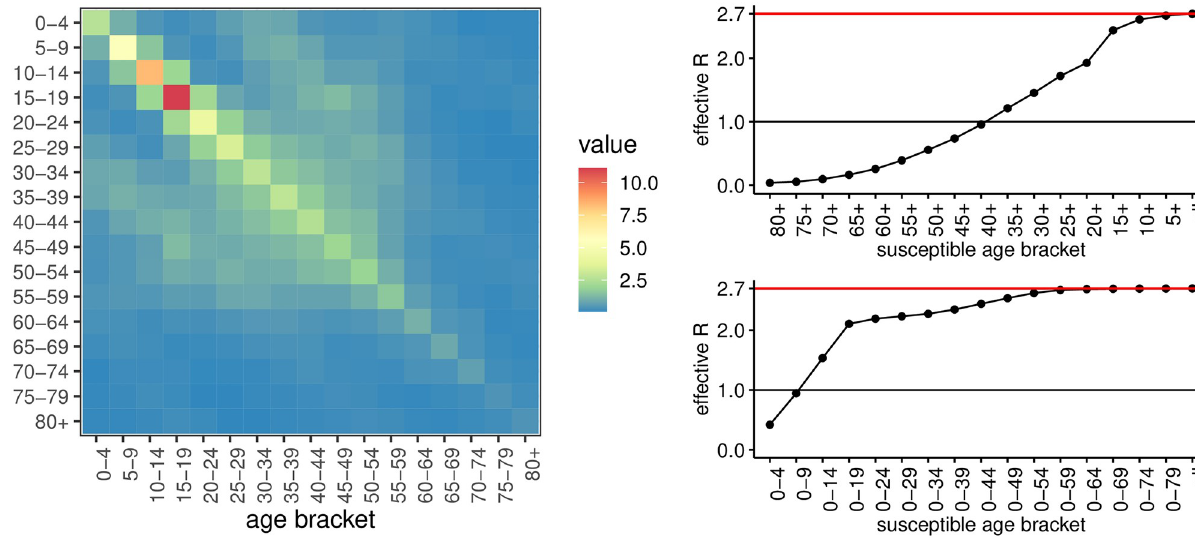
Fig 1. Left : The contact matrix we use, derived from the contact matrix generated in [3] for the United States. Right : Basic reproduction of an epidemic restricted to top- and bottom-segments of population by age, respectively, where the entire population corresponds to an R 0 = 2.7. Note : these figures assume young children pose a transmission risk equal to that of adults. We show corresponding figures where children pose a lower transmission risk in Section